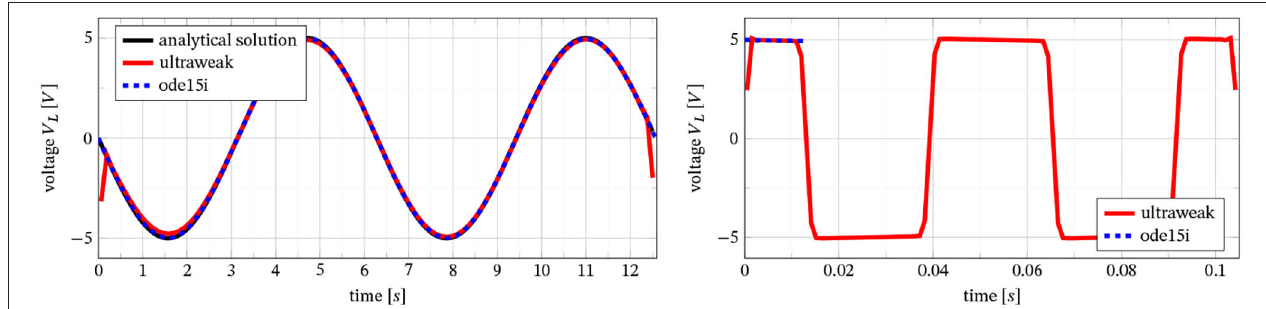
FIGURE 2 | Serial RLC circuit, the exact voltage at the inductor; comparison of time-stepping (ode15i – blue) and ultraweak (red) approximation for smooth f smooth V (left, including analytical solution) and discontinuous f disc V